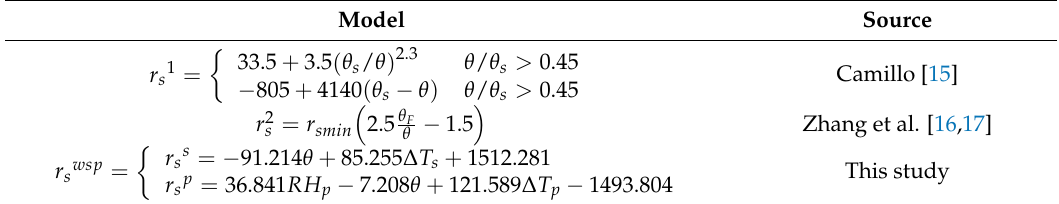
Table 5. The types and sources of Soil surface resistance models.